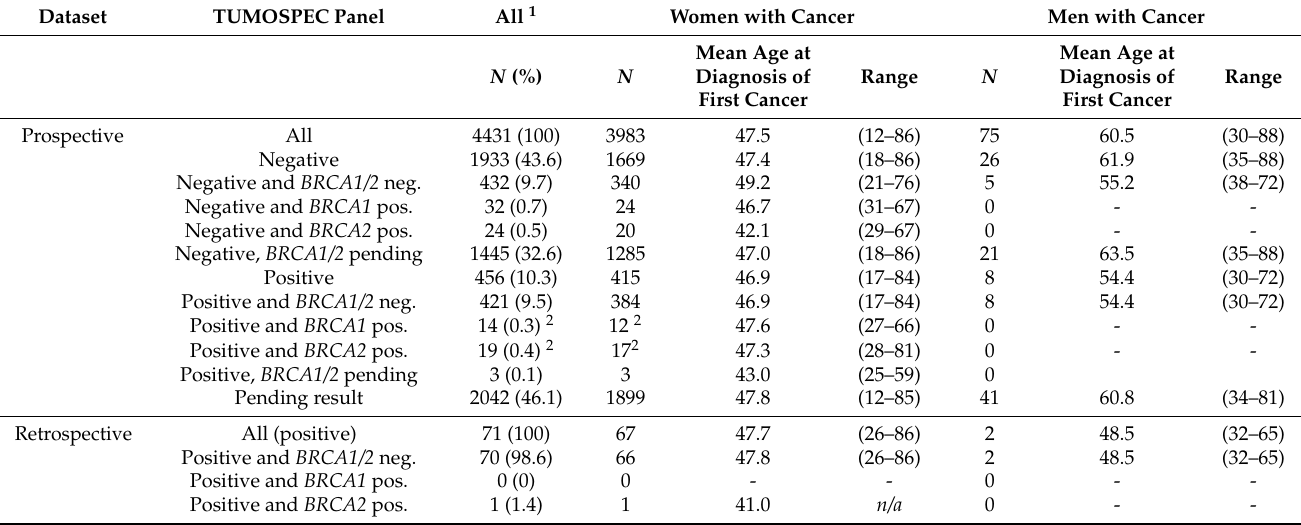
Table 2. Distribution of index cases, according to result of the genetic